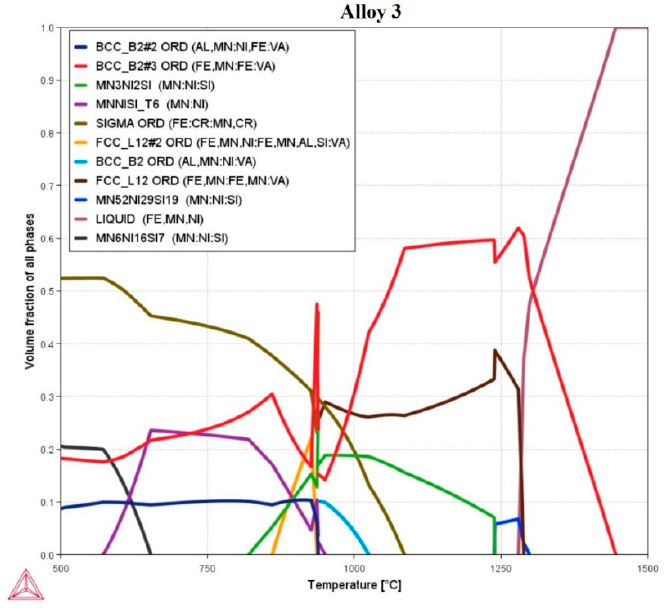
Figure 4. Phase diagram of Alloy 3 (Fe 35 Mn 25 Ni 15 Cr 15 Al 5 Si 5 ) HEA.